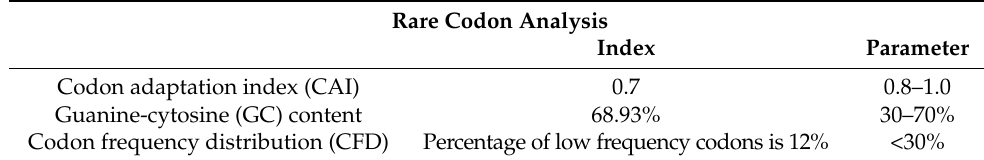
Figure 1. Complete amino acid sequence of human TNF- α . The highlighted part (amino acids 77–233) is the sequence of the human TNF-α soluble form. Table 1. Rare codon analysis results of DNA coding sequence for human TNF-α.